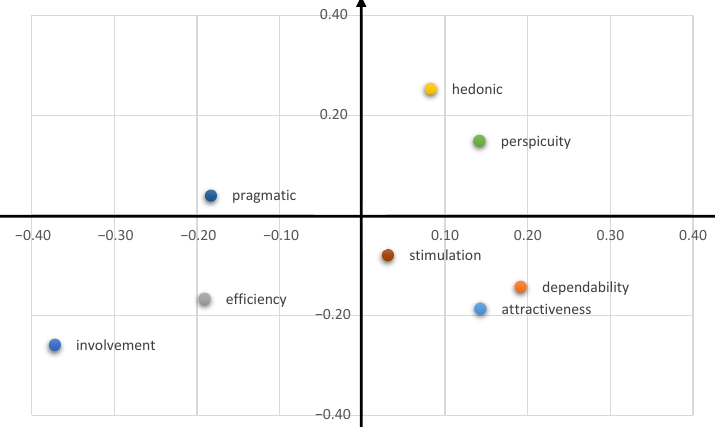
Figure 17. Mapping the extracted dimensions IN THE Kano